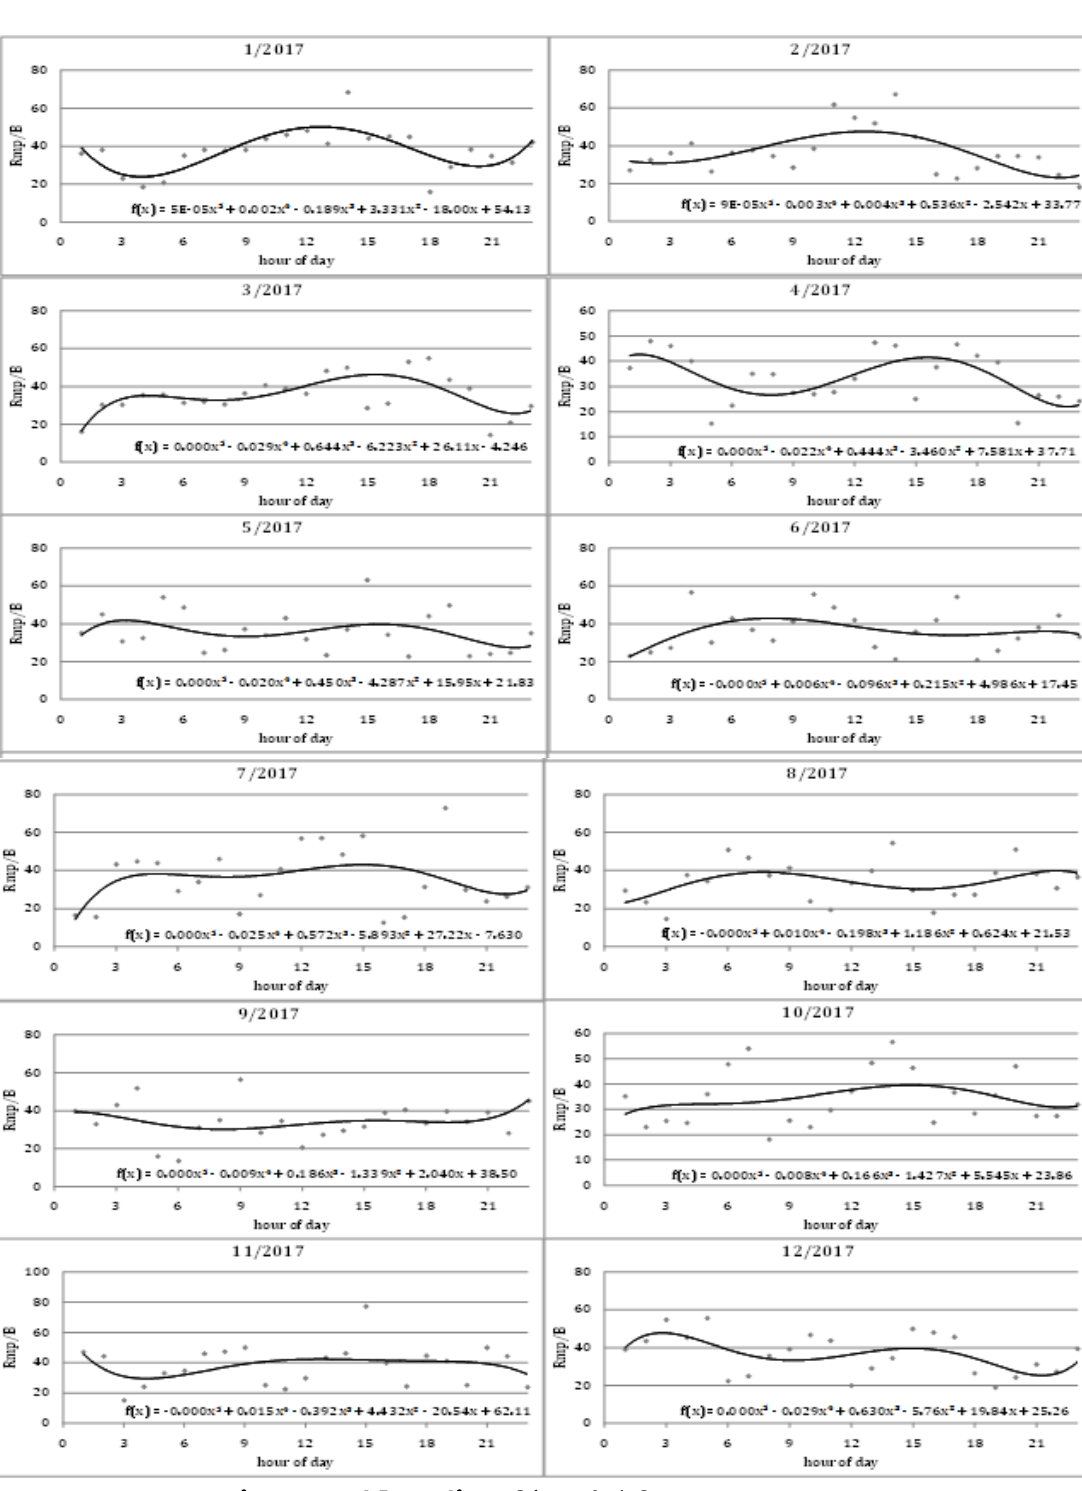
/B ) for year mp o